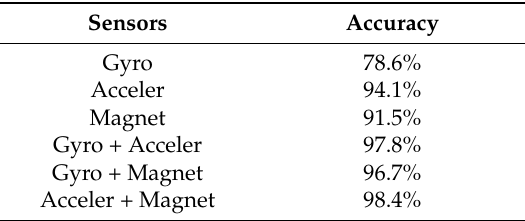
Table 5. Correct differentiation rates of sensor combinations.